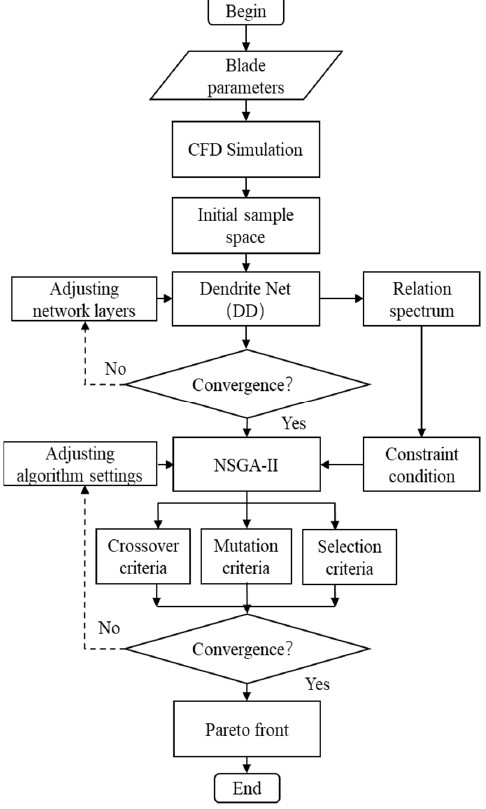
Figure 7. Optimization process.